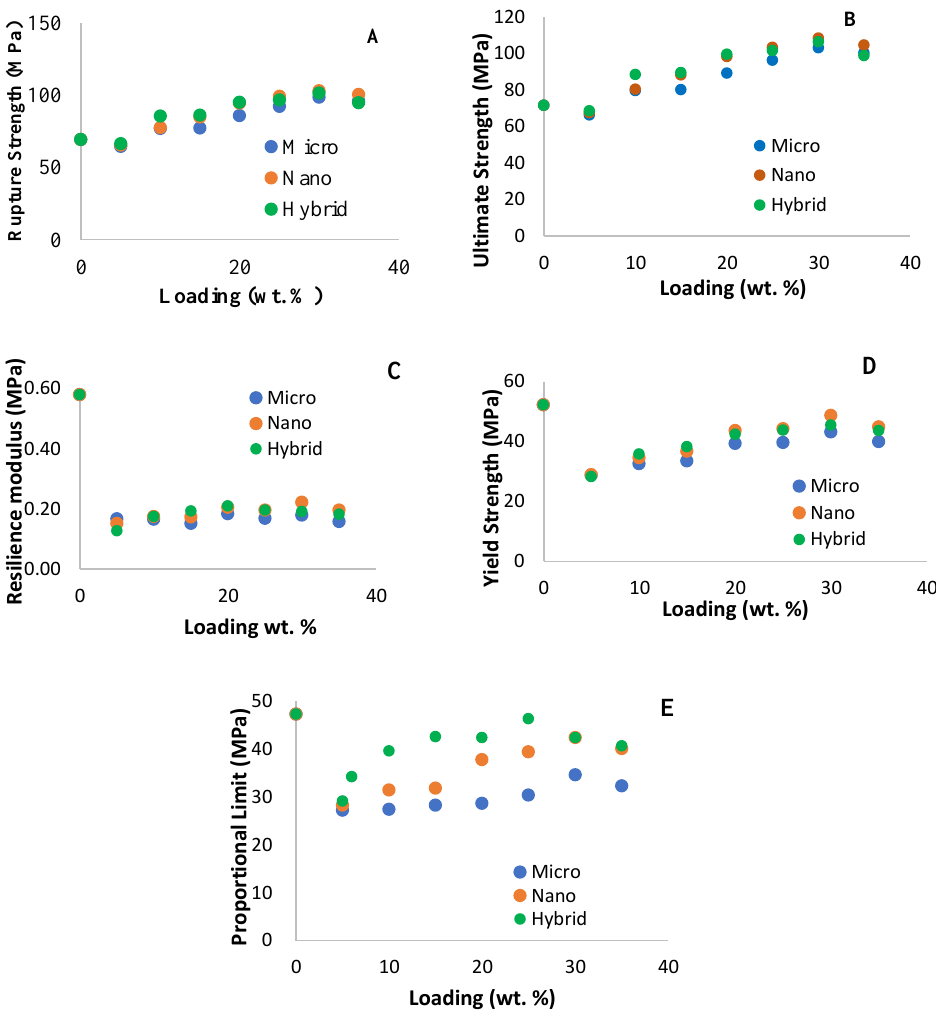
Figure 3. Comparison between Micro, Nano and Hybrid silica composite with respect to Rupture modulus ( A ), Ultimate modulus ( B ), Resilience modulus ( C ), Yield strength ( D ) and Proportional limit ( E ).